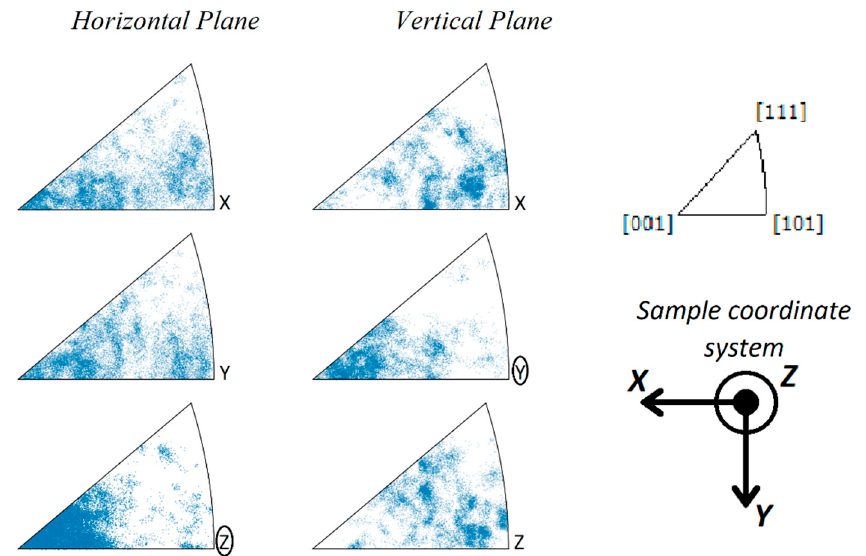
Figure 6. Inverse pole figure (IPF) charts obtained from electron backscatter diffraction (EBSD) analysis on the horizontal and vertical planes of SLM Inconel 718. [001] texture was detected on the IPF Z axis on the horizontal plane and on the IPF Y axis on the vertical plane.